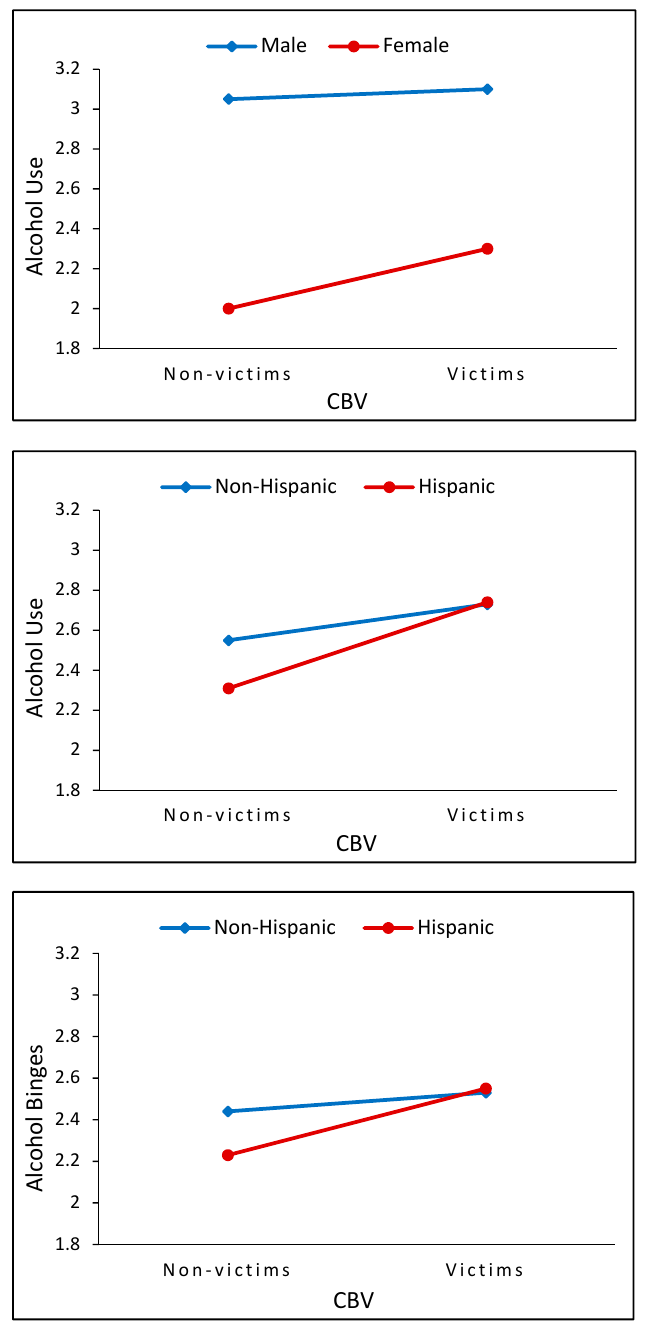
Figure 3. The moderating roles of gender on the effect of CBV on alcohol use ( top ; p < 0.05), ethnicity on the effect of CBV on alcohol use ( middle ; p < 0.01), and ethnicity on the effect of CBV on alcohol binges ( bottom ; p < 0.05).